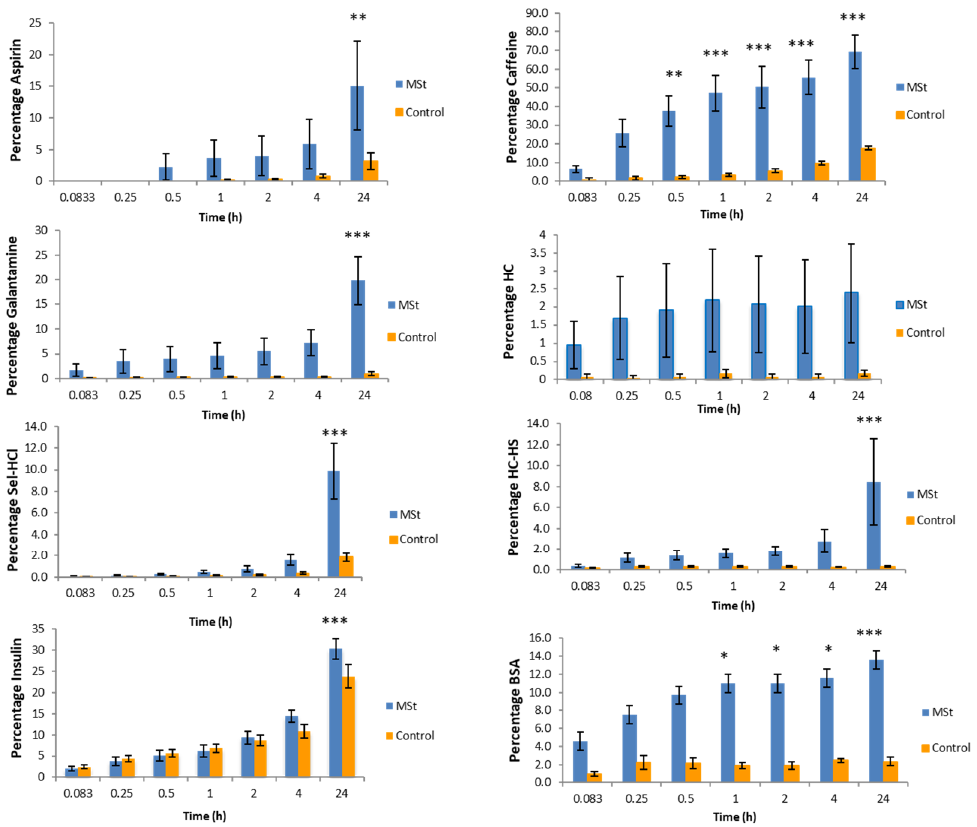
Figure 6. Percentage of total drug present in the receptor chamber over 24 h. Values are ± standard error. Significance difference ( p ≤ 0.05 one-way ANOVA) is indicated by (*). p ≤ 0.01 and p ≤ 0.001 are indicated by (**) and (***) respectively ( n = 9).